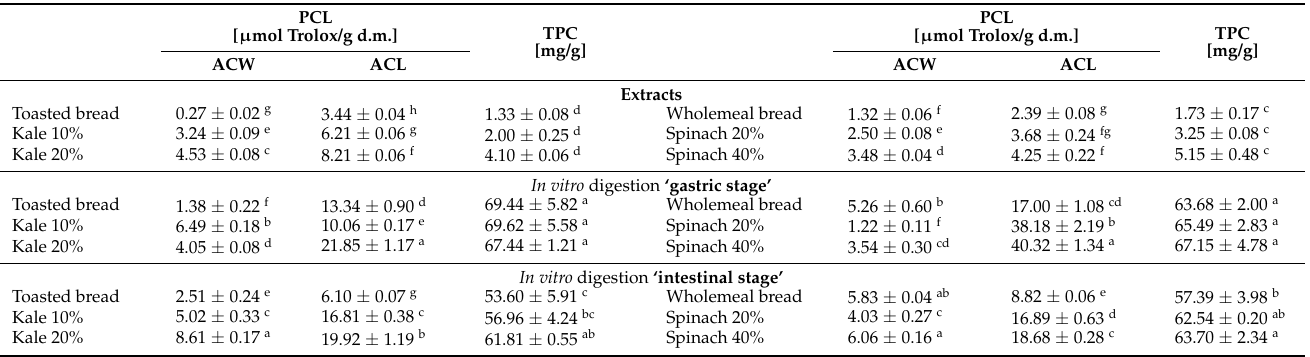
Table 2. The total phenolic content (TPC) and antioxidant activity (extracts (a) and after the in vitro digestion (b)) of breads measured by Folin’s reagent (mg/g), and the PCL, ACW, and ACL methods ( µ mol Trolox/g d.m.). PCL [ µ mol Trolox/g d.m.] TPC